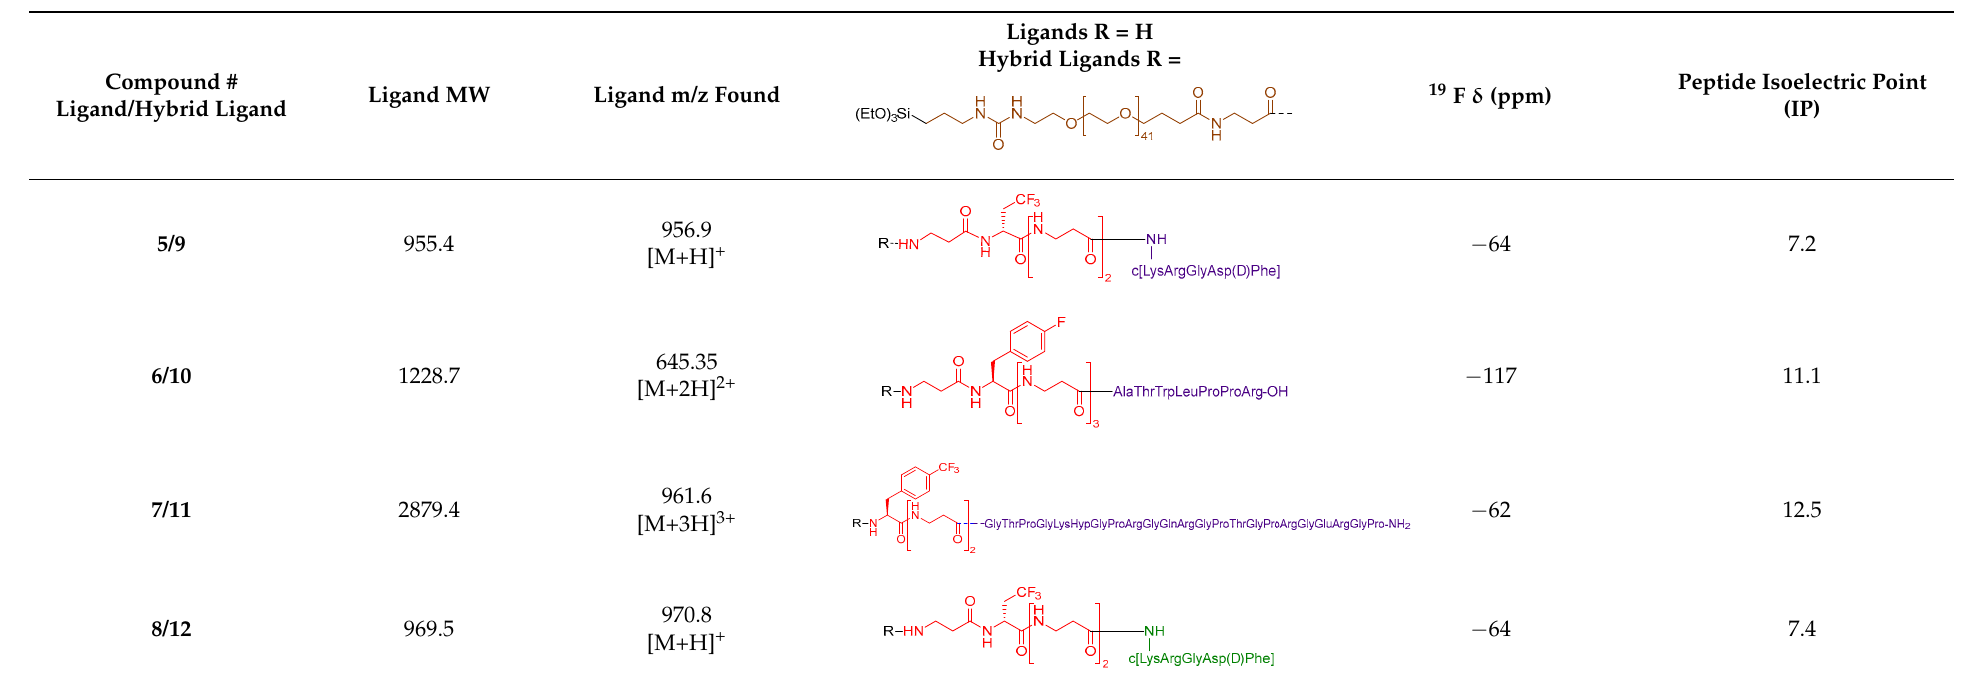
Table 3. Peptides 5–8 and corresponding hybrid ligands 9–12.